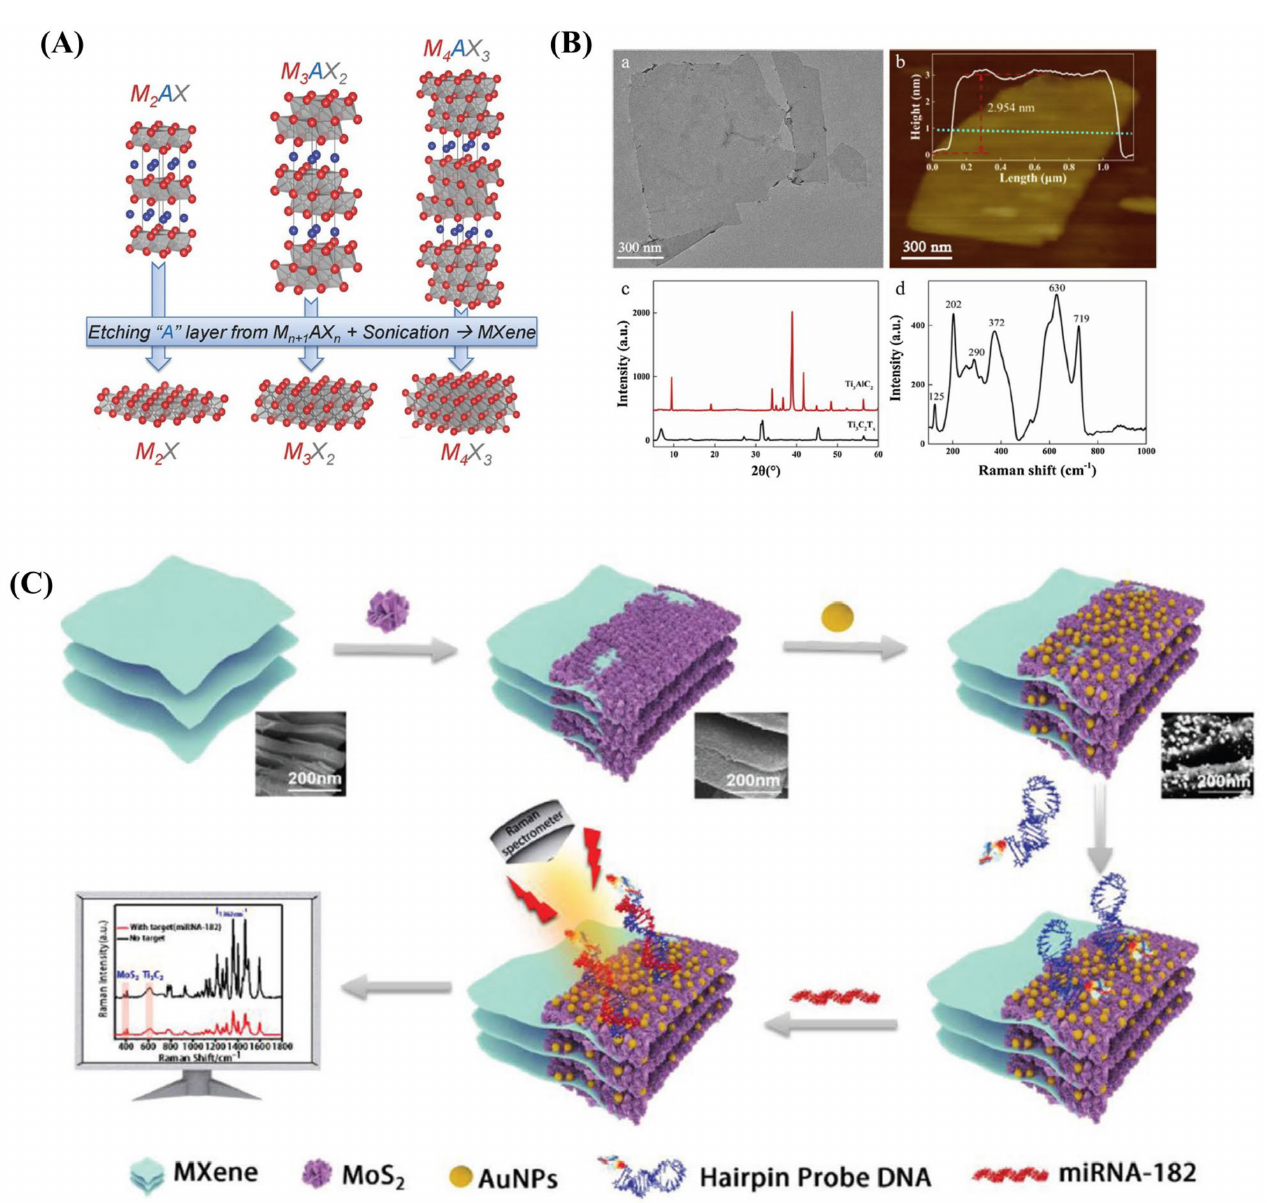
Figure 6. ( A ) Structure of MAX phases and the corresponding MXenes [161]. ( B ) ( a ) TEM, ( b ) AFM, ( c ) XRD and ( d ) Raman spectra of Ti 3 C 2 Tx nanosheets [159]. ( C ) Schematic illustration of a self- calibrated SERS strategy based on Mxene/MoS 2 @AuNPs ternary system for the ultrasensitive